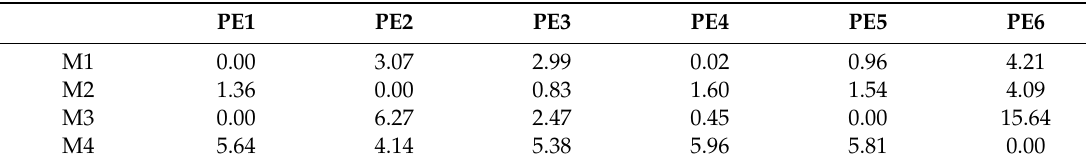
Table 4. Variation in borehole design length subject to PE.